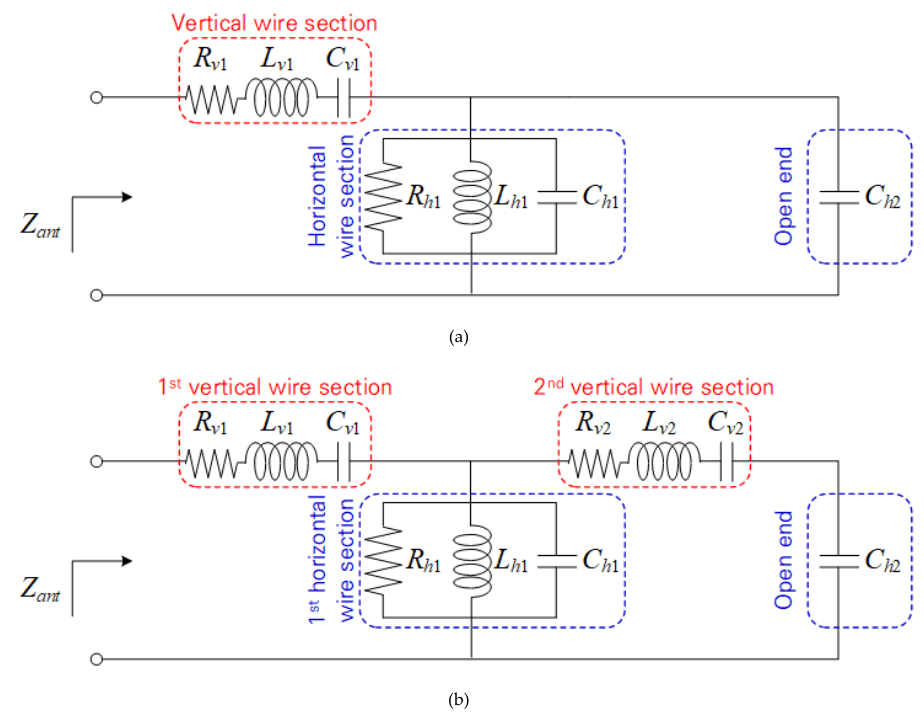
Figure 6. Possible equivalent circuits corresponding to two types of antennas in Table 6: ( a ) possible equivalent circuit of the antennas with rank 6; ( b ) possible equivalent circuit of the antennas with rank